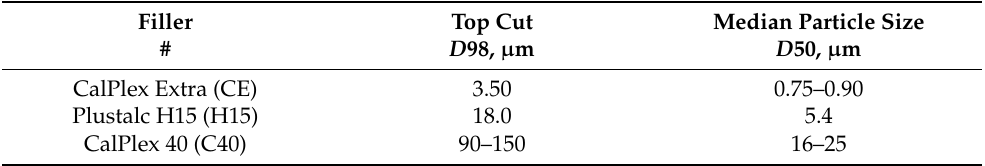
Table 1. Physical properties of the applied fillers. Filler Top Cut